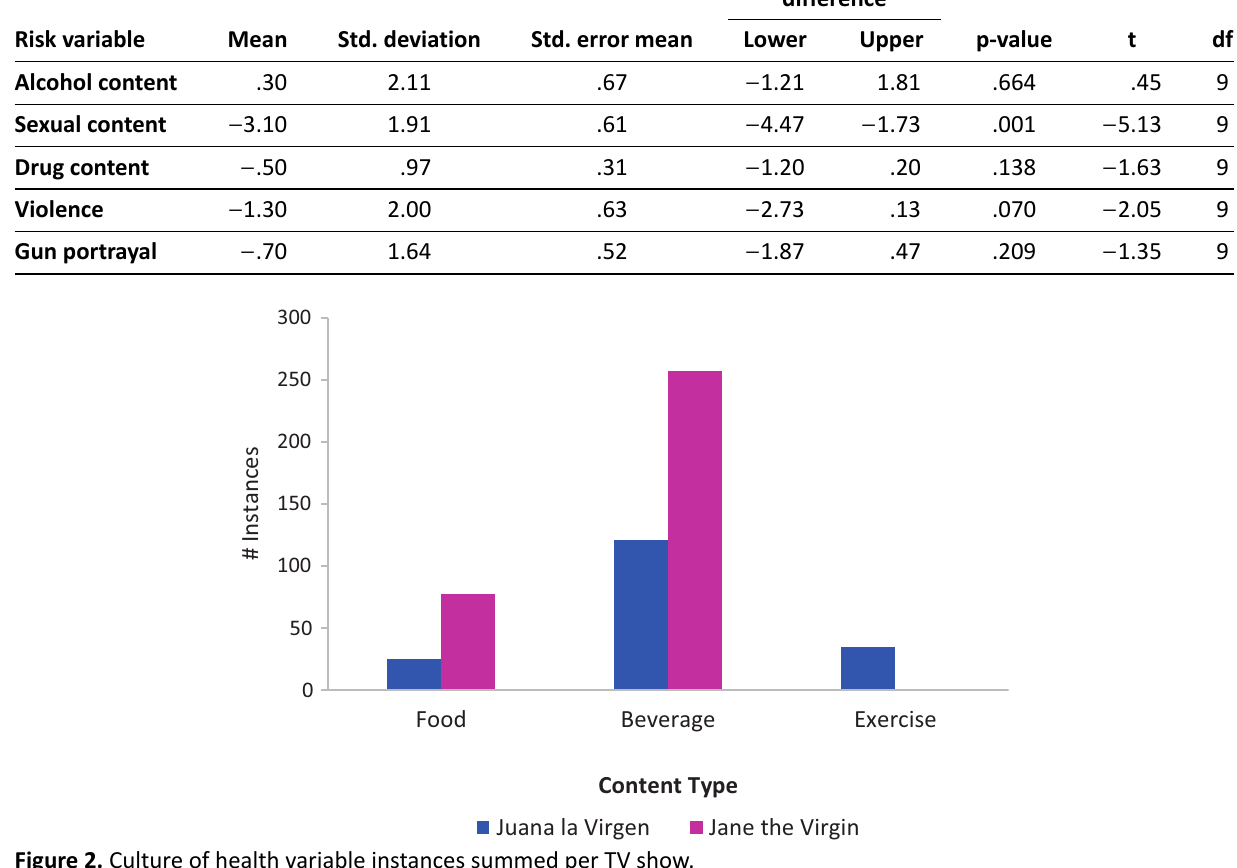
Figure 2. Culture of health variable instances summed per TV show. Table 2. Culture of health categories for “Jane the Virgin” v. “Juana la Virgen” (paired